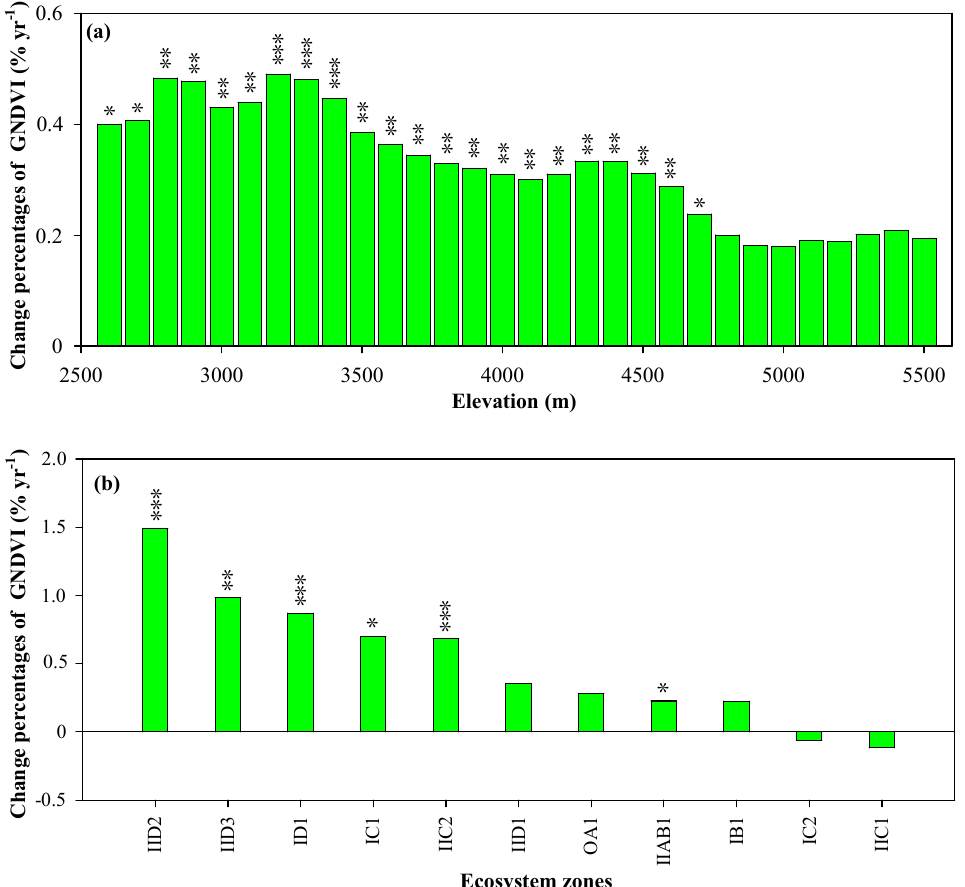
Figure 3. Change percentages of growing season NDVI (GNDVI) across different elevation bins ( a ) and ecosystem zones ( b ) on the Tibetan Plateau (TP). *** p < 0.001; ** p < 0.01; * p < 0.05.